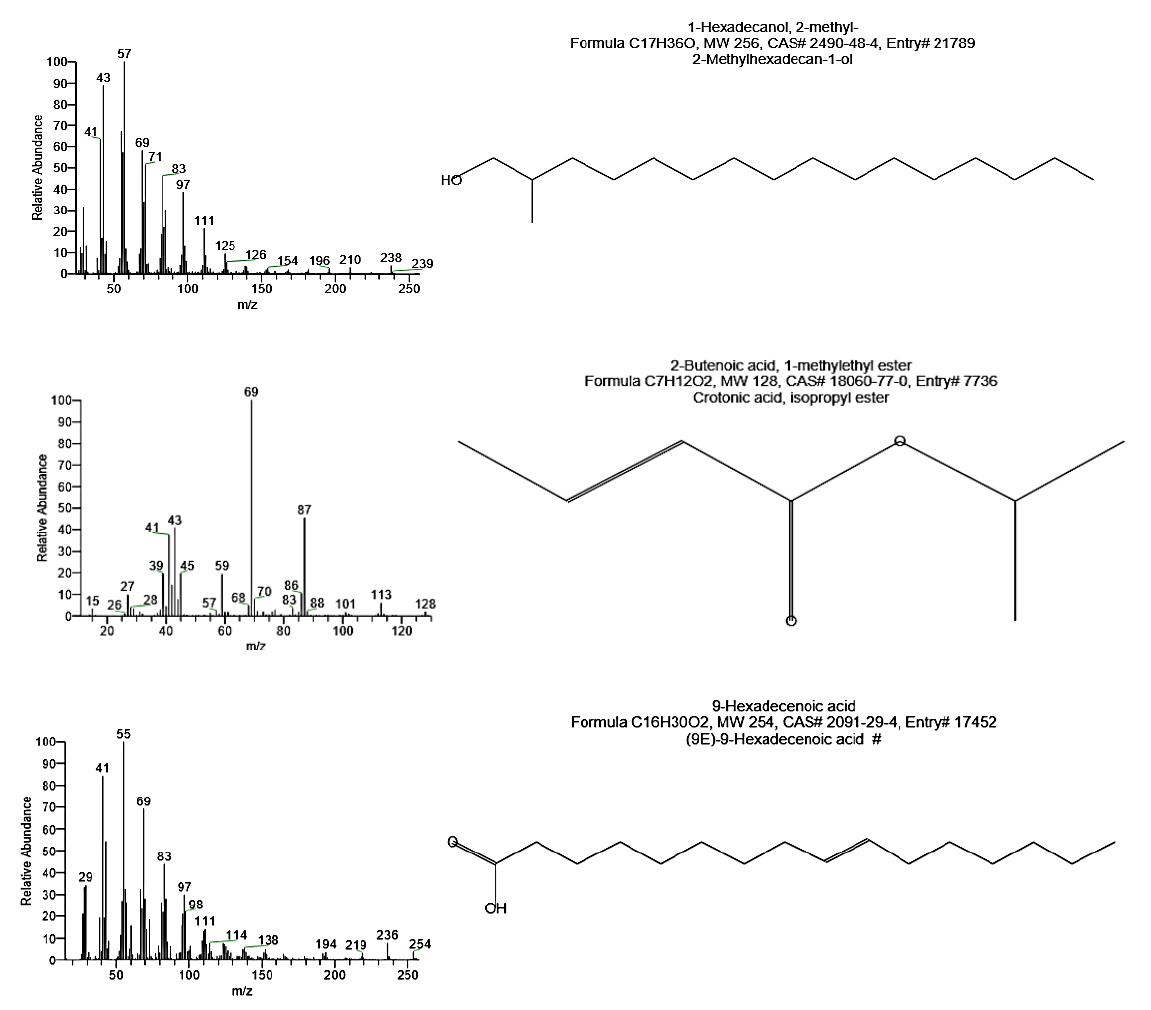
Figure 5. GC-mass spectra of polyhydroxybutyrate (PHB) extracted from Bacillus wiedmannii strain.